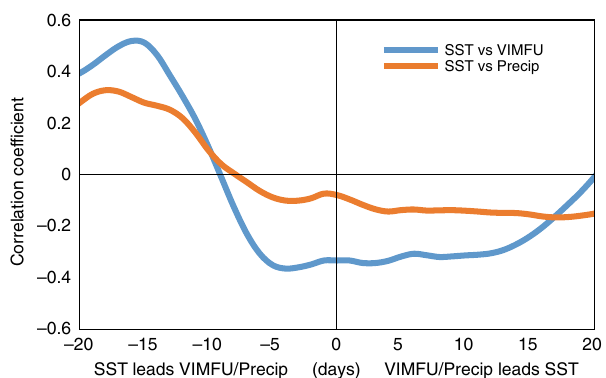
Fig. 6 Lead – lag analysis of sea surface temperature vs moisture transport and precipitation. Lead-lag correlation between sea surface temperature (SST) and the zonal component of the vertically integrated moisture fl ux (VIMFU, moist westerlies) and precipitation. SST is averaged over the